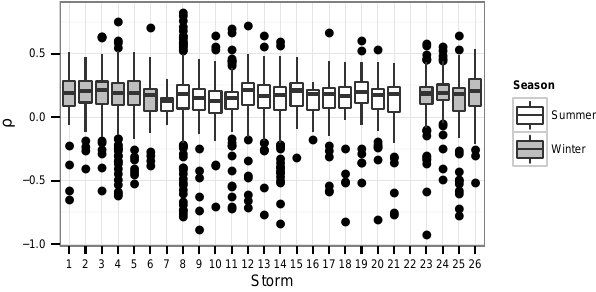
Figure 14. The correlations of all scales for each of the storms. Note that almost all rainfall fields exhibit correlations, and that almost all of them are positive.